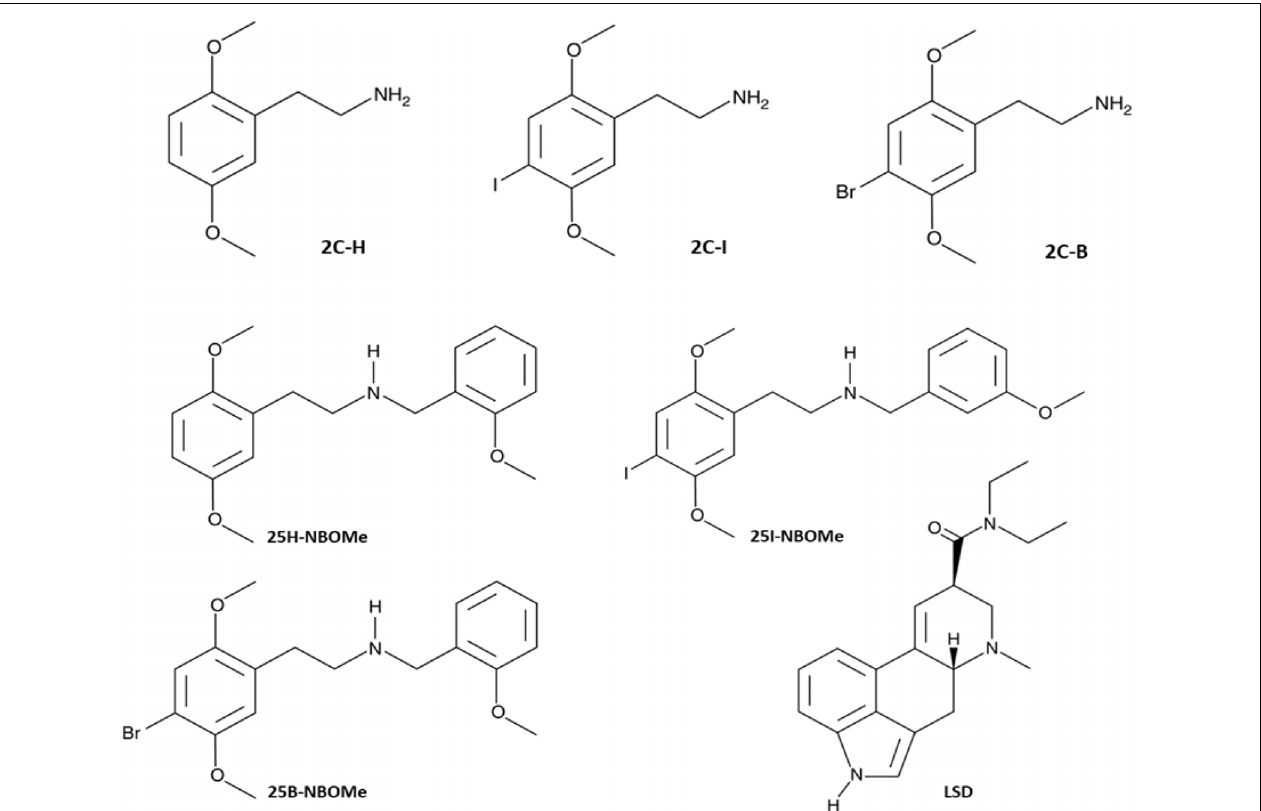
FIGURE 1 | Chemical structures of 2,5-dimethoxyphenethylamine (2C-H), 2,5-Dimethoxy-4-iodophenethylamine (2C-I), 2,5-dimethoxy-4-bromophenethylamine (2C-B), 2,5-dimethoxy-N-[(2-methoxyphenyl) methyl]-benzeneethanamine (25H-NBOMe), 4-iodio-2,5-dimethoxy-N-[(2-methoxyphenyl) methyl]-benzeneethanamine (25I-NBOMe), 4-bromo-2,5-dimethoxy-N-[(2-methoxyphenyl) methyl]-benzeneethanamine (25B-NBOMe), and Lysergic acid diethylamide